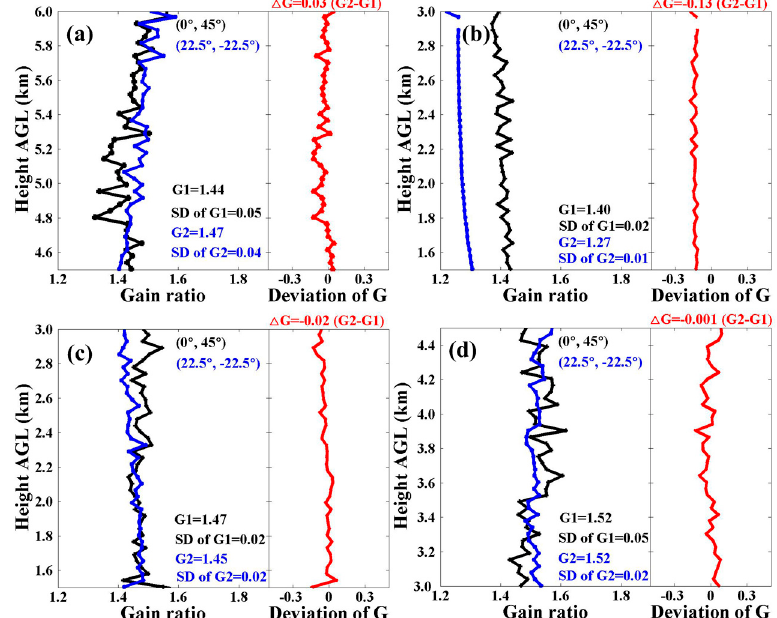
Figure 4. Gain ratio determined with different measurement groups of (0 ° , 45 ° ) and (22.5 ° , − 22.5 ° ) in the calibration range on ( a ) 21 September 2015, Qingdao; ( b ) 08 January 2016, Qingdao; ( c ) 18 January 2016, Qingdao and ( d ) 19 January 2016, Qingdao. The black lines indicate the gain ratio determined with measurement group of (0 ° , 45 ° ) and the blue lines denote the gain ratio determined with measurement group of (22.5 ° , − 22.5 ° ). The red lines are the gain ratio differences.